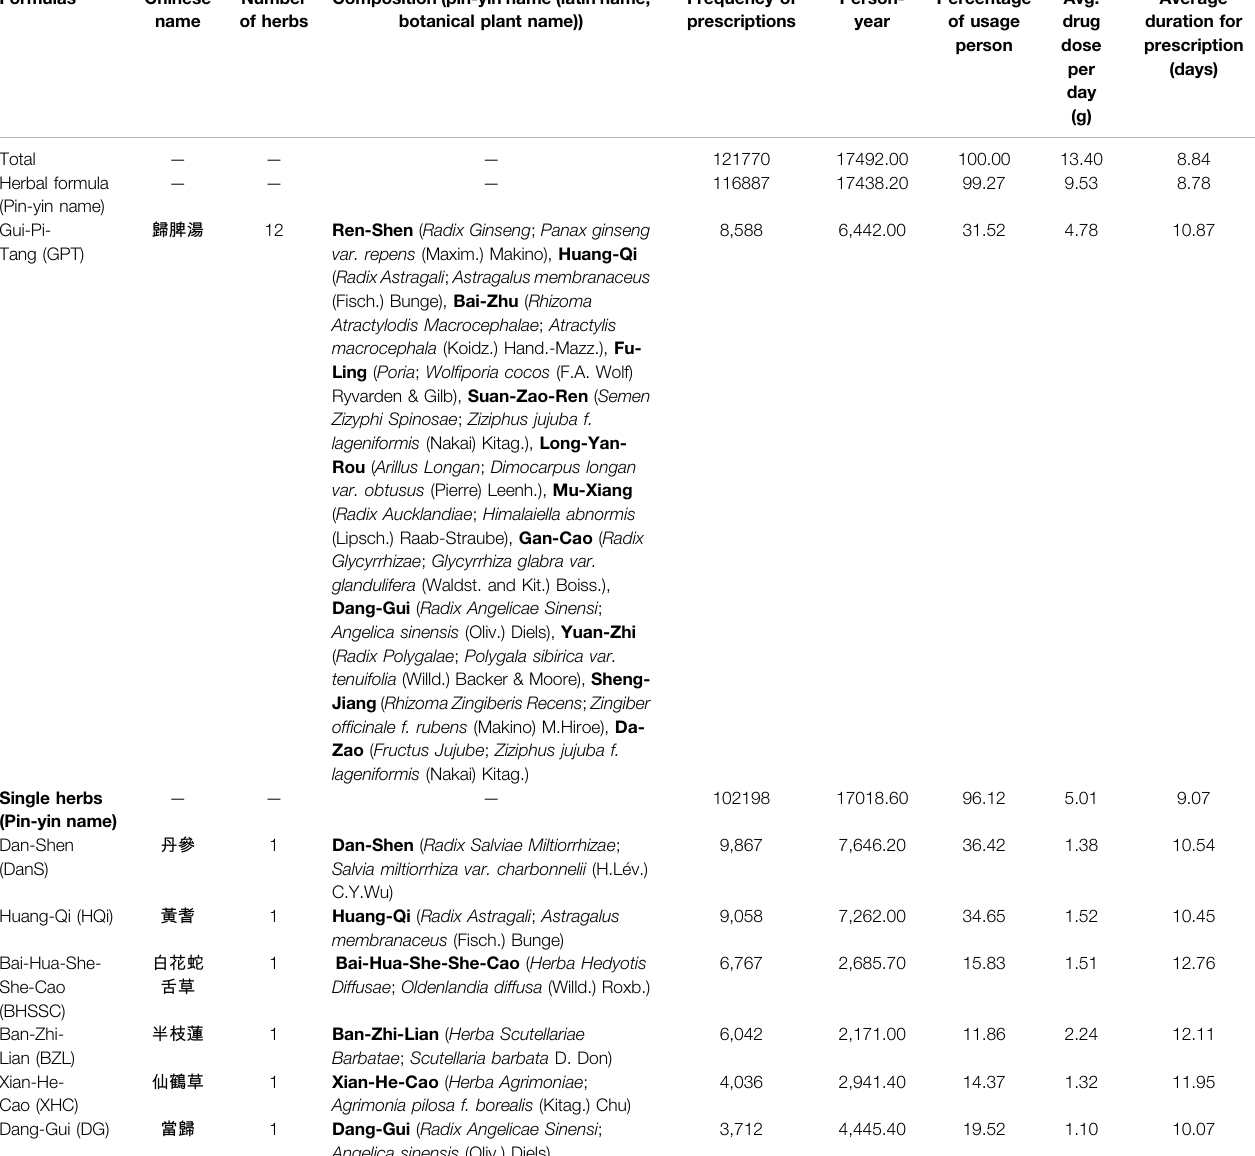
TABLE 2 | Composition of the most commonly used herbal formulas and single herbs for patients with aplastic anemia in Taiwan.